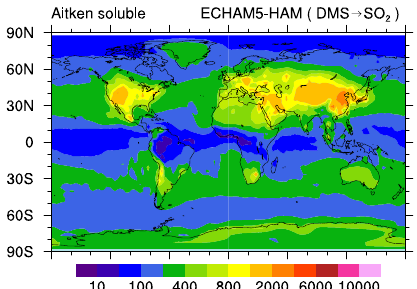
Fig. 4. Annual mean number concentration of the soluble Aitken mode particles at the lowest model level, simulated by ECHAM5- HAM in the experiment in which the methane sulfonic acid (MSA) converted from dimethyl sulfide (DMS) is not assumed to occur as sulfuric acid. . The unit is number of particles per cubic centimeter at the standard atmospheric state (1013.25hPa,